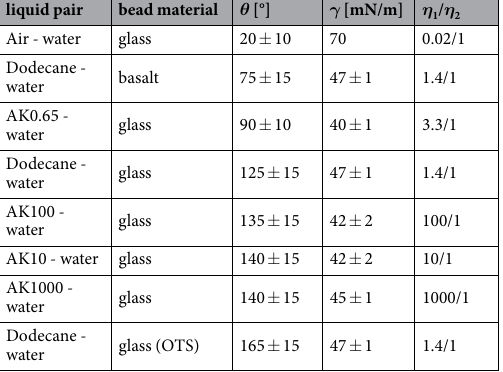
Table 1. Summary of the (advancing) contact angles θ of the invading phase on the beads, surface tension γ between the invading and defending phase, and the viscosity ratios η 1 / η 2 of invading and defending phase for different materials combinations used in this